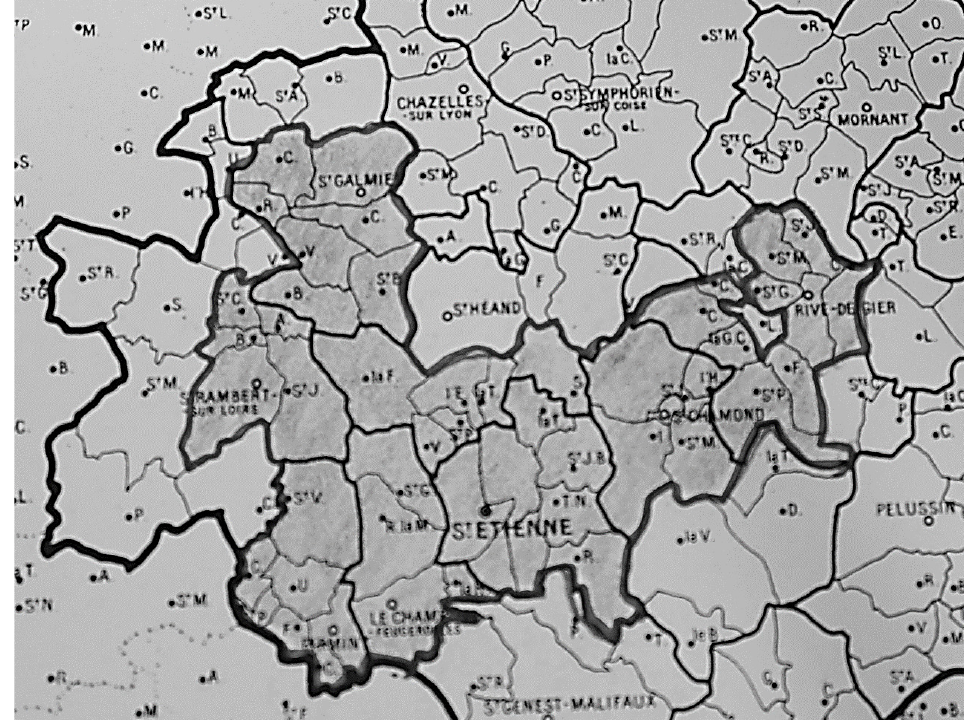
Figure 4. Spatial perimeter covered by the local SDAU process. Source: Epures